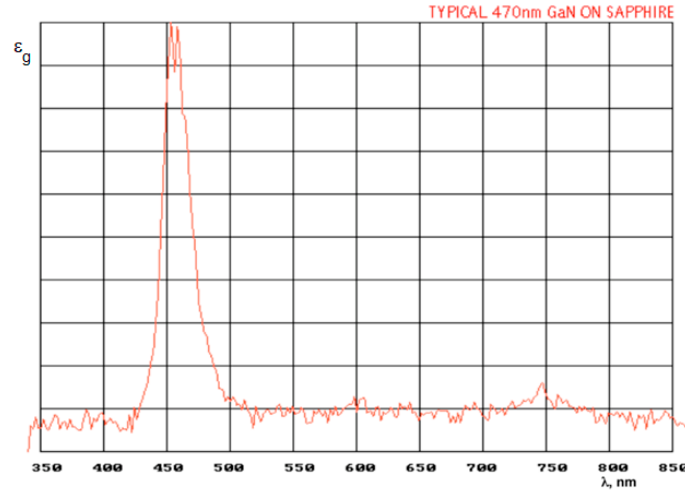
Figure 3. Light absorption spectrum for ITERM-12 oil.